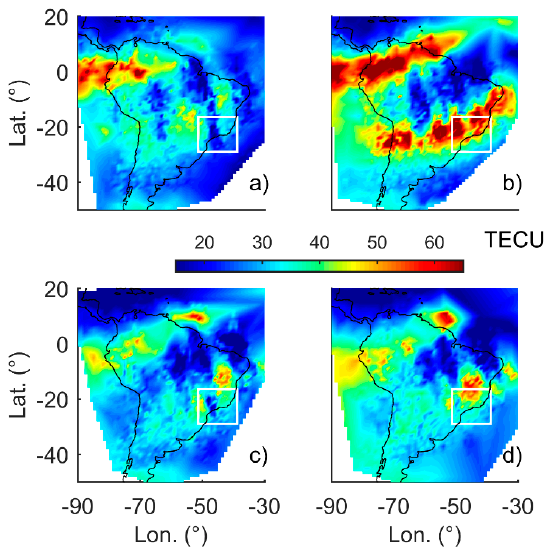
Figure 8. Four cases to build the confusion matrix using the VTEC reconstructions over all the South America region. The white square shows the coverage of the CHPI images.